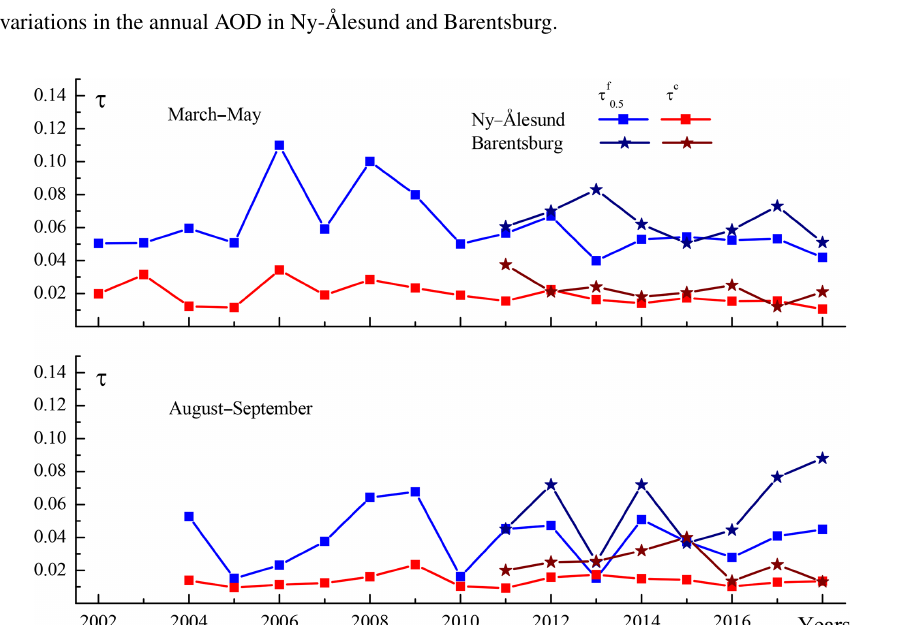
Figure 7. Multiyear variations in τ f and τ c for the periods of the spring maximum and fall minimum of AOD in two regions on Spitsbergen. 0 . 5 /τ c ) and the α exponent are Ny-Ålesund, and the ratio ( τ f 0 . 5 /τ c ) = 2 . 92 and α = 1 . almost the same: ( τ f 0 . 5